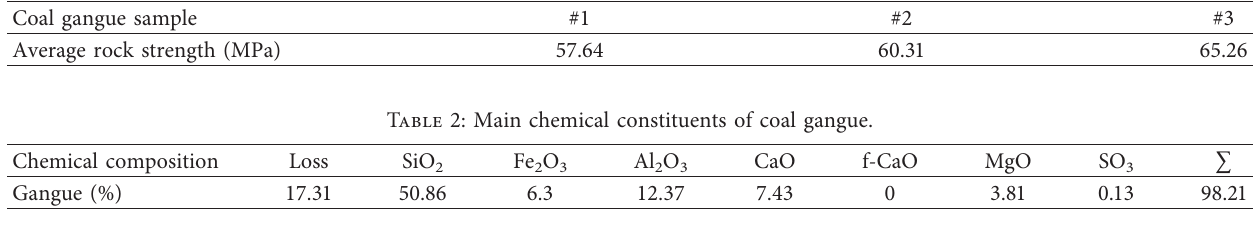
Table 1: Uniaxial compressive strength of noncombustible coal gangue.